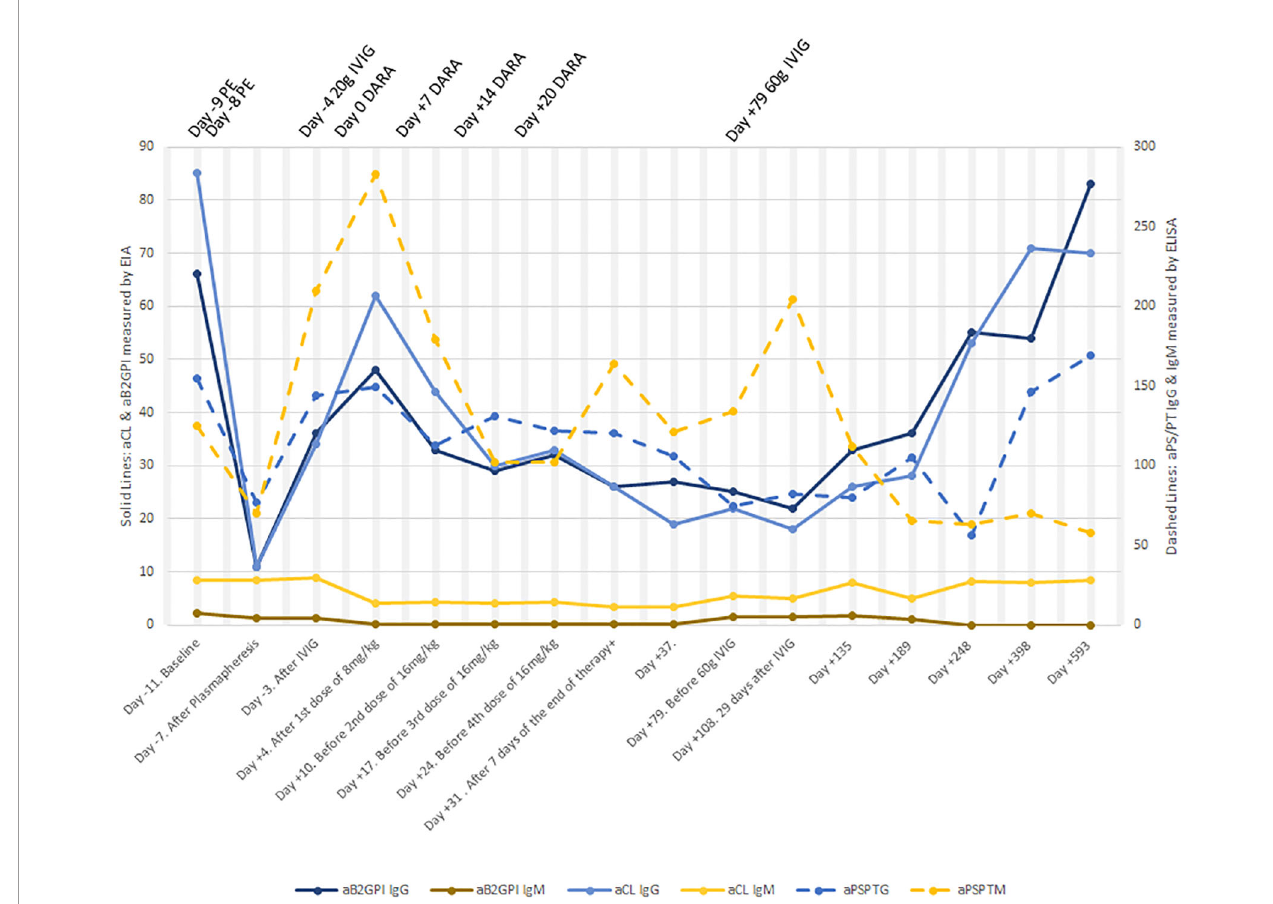
FIGURE 1 | Change in aPL levels before and after therapy. An extreme drop in aPL levels lasting for 4 days was observed after two sessions of plasmapheresis. aPS/PT IgM values even rose to higher levels than in baseline after plasmapheresis. One week after the fi rst dose of daratumumab was administered, aCL IgG and aB2GPI IgG started a decline, this decline lasting until day +108. After day +108, a signi fi cant climb began. Levels of aPS/PT IgG lowered until day +248 and then went up again. Levels of aPS/PT IgM showed an intermittent up and down pro fi le, but they have remained stable at half the titer of baseline from day +189 and onwards. PE, plasmapheresis; DARA,